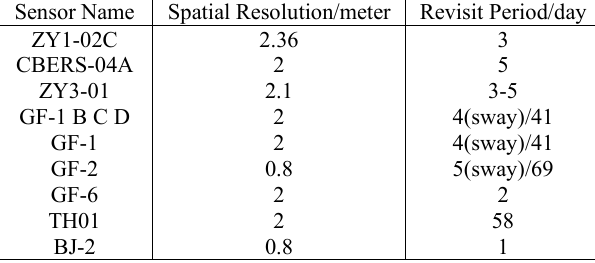
Table1. Some technical parameters of the satellite images